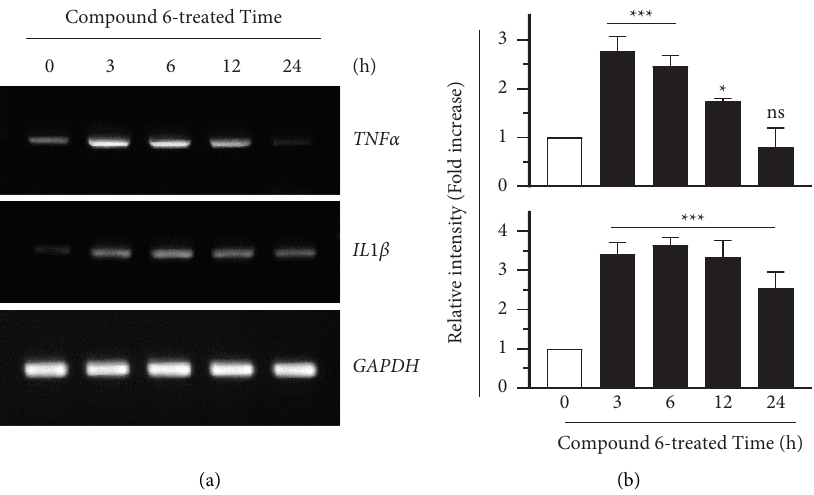
Figure 5: Efect of compound 6 on TLR7-mediated innate cytokines expression. THP1 cells were treated with 40 μ M compound 6 for various periods (0–24h). (a) TNF α and IL1 β mRNA levels were determined using RT-PCR (a). GAPDH mRNA levels were used as an internal control. (b) PCR band intensities were measured using the Image J software. Bars represent the mean ± S.D. ( n � 3). ns: not signifcant, ∗ p < 0 . 05, and ∗∗∗ p < 0 . 001 by Dunnett’s multiple comparisons test.